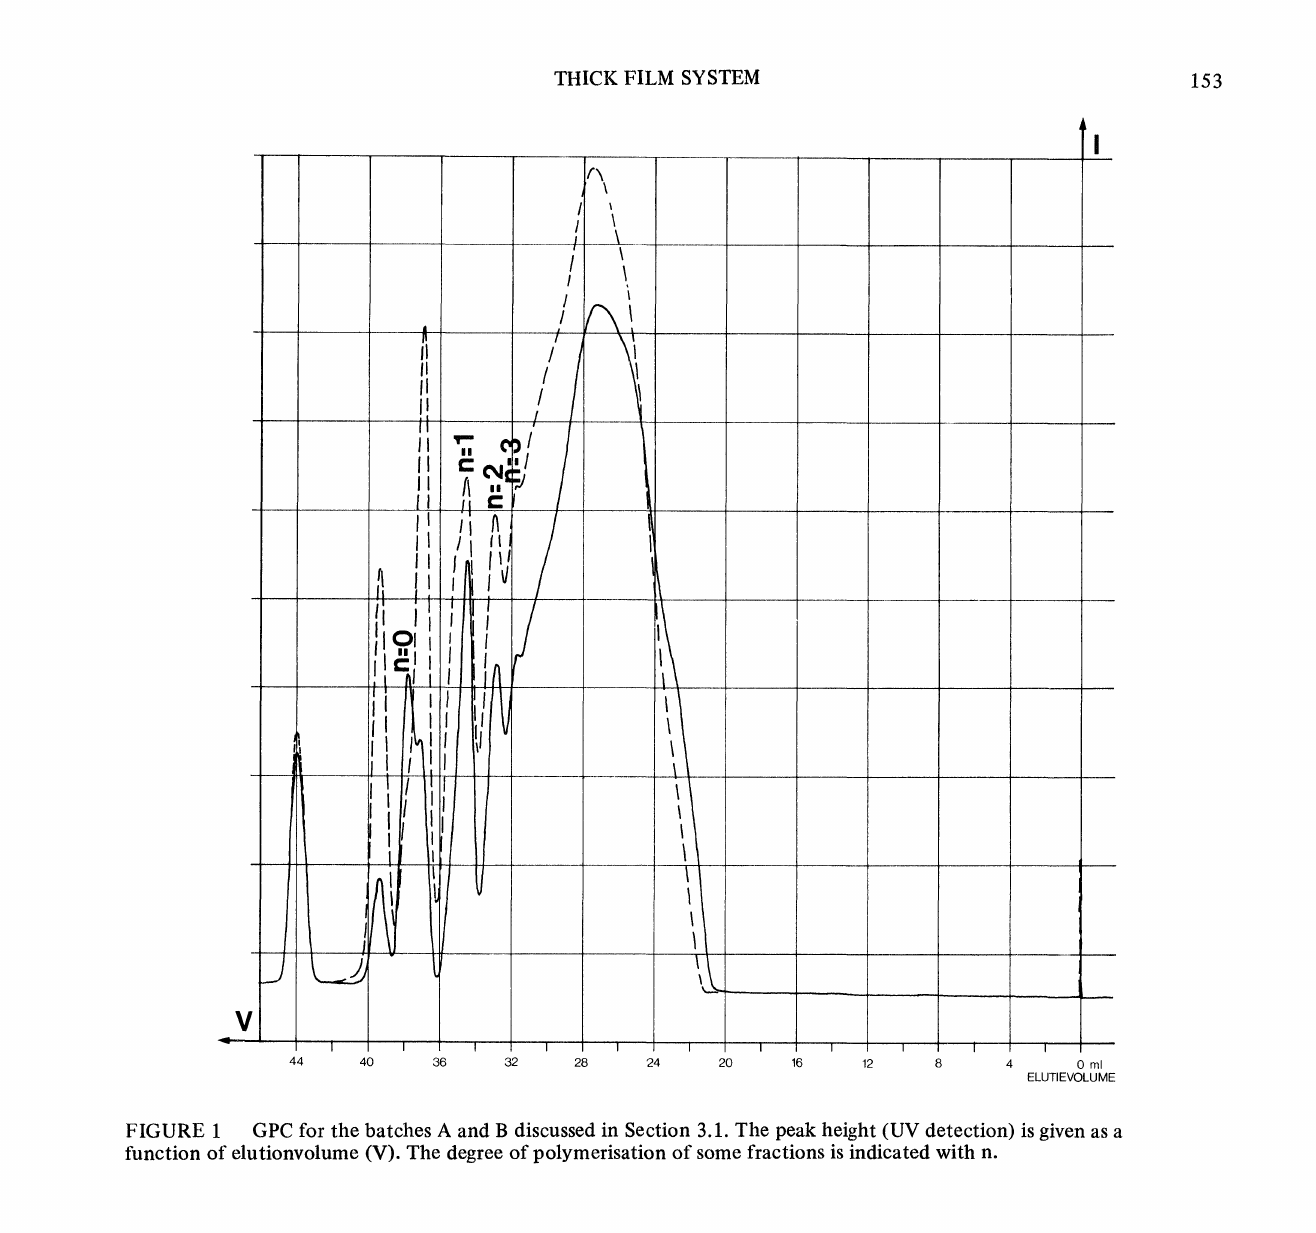
TABLE II Influence of carbon morphologies. Some typical values for the sheet resistivity (Rn) and the temperature coefficient of resistance (TCR) Carbon